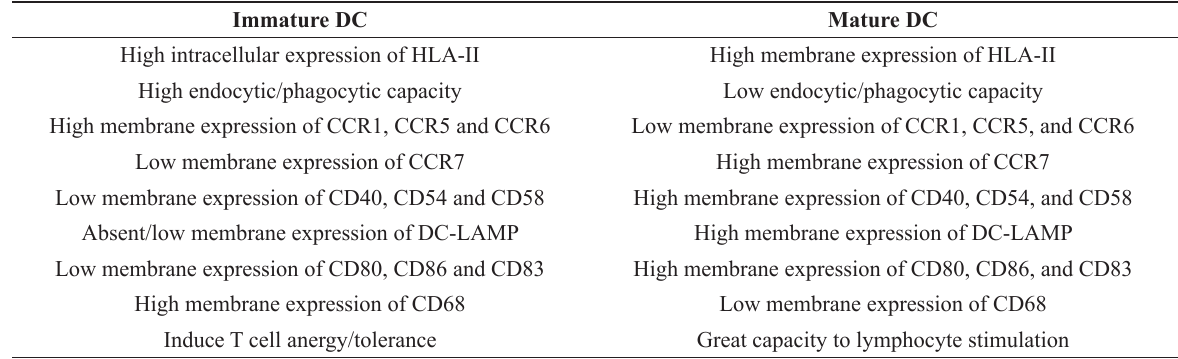
Characteristics of DCs according to different maturation stages. The characteristics described refers to the expression in the plasma